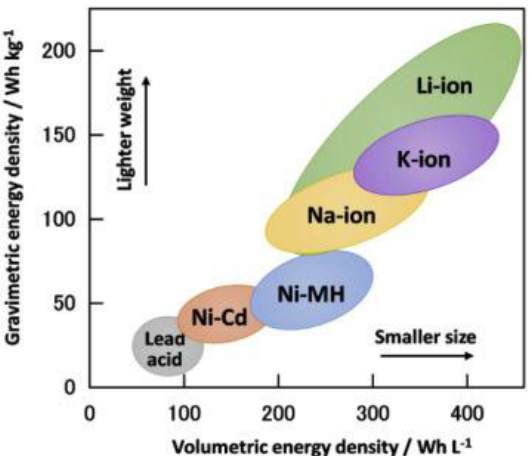
Figure 1. Comparison of different battery chemistries.